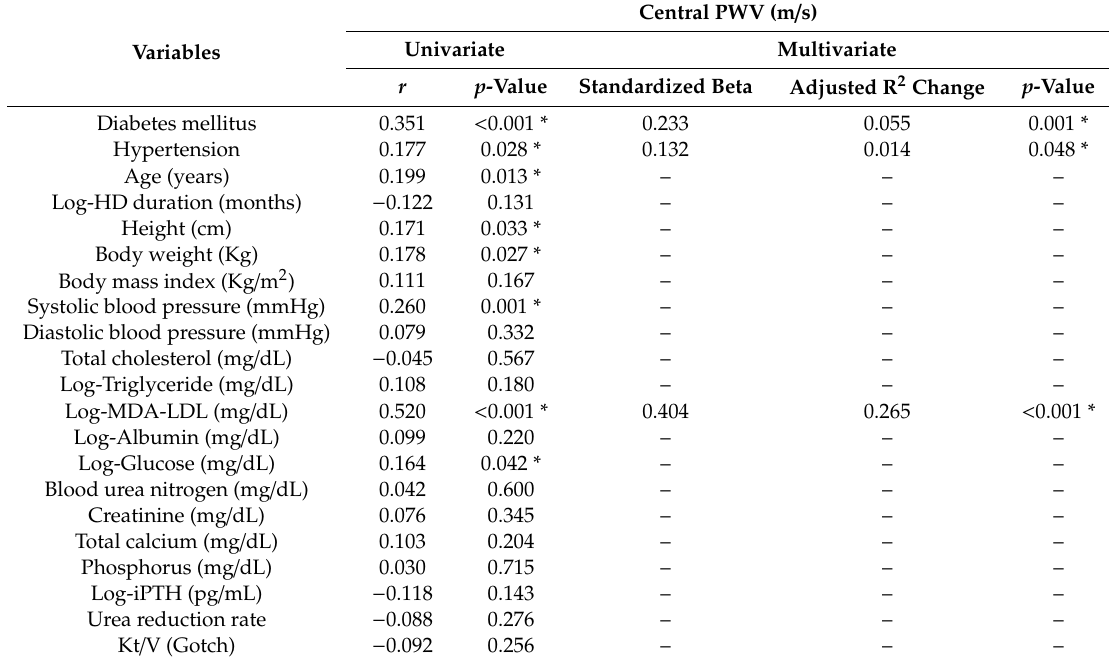
Table 3. Correlation between central PWV levels and clinical variables among 155 HD